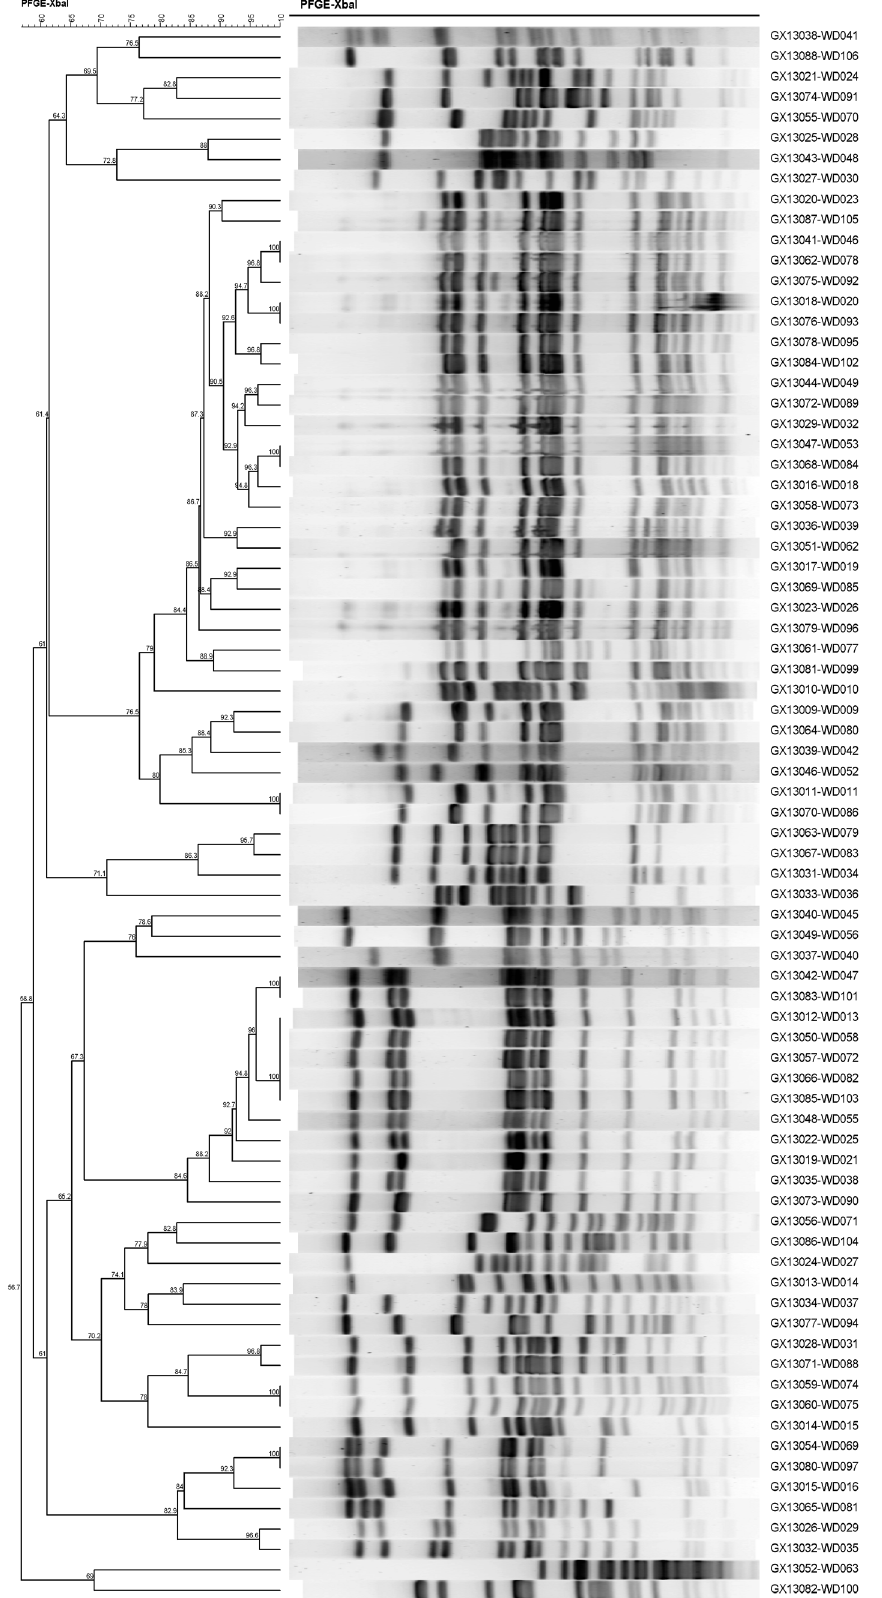
Figure 6. Comparison of PFGE patterns for isolates with high similarity. doi:10.1371/journal.pone.0110876.g006 PLOS ONE |